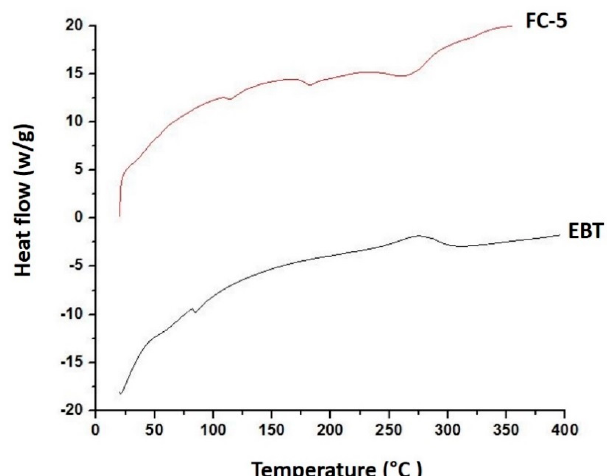
Figure 7. DSC curves of pure EBT and micelles-loaded orodispersible sublingual film (FC-5).